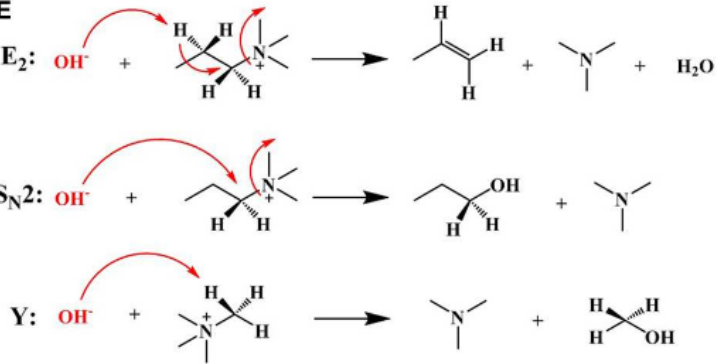
Figure 1. Possible degradation mechanisms of QA cations in alkaline solutions: Hofmann elimination reaction (E2), nucleophilic substitution (S N 2), and Ylide formation (Y). Reprinted from Ref.